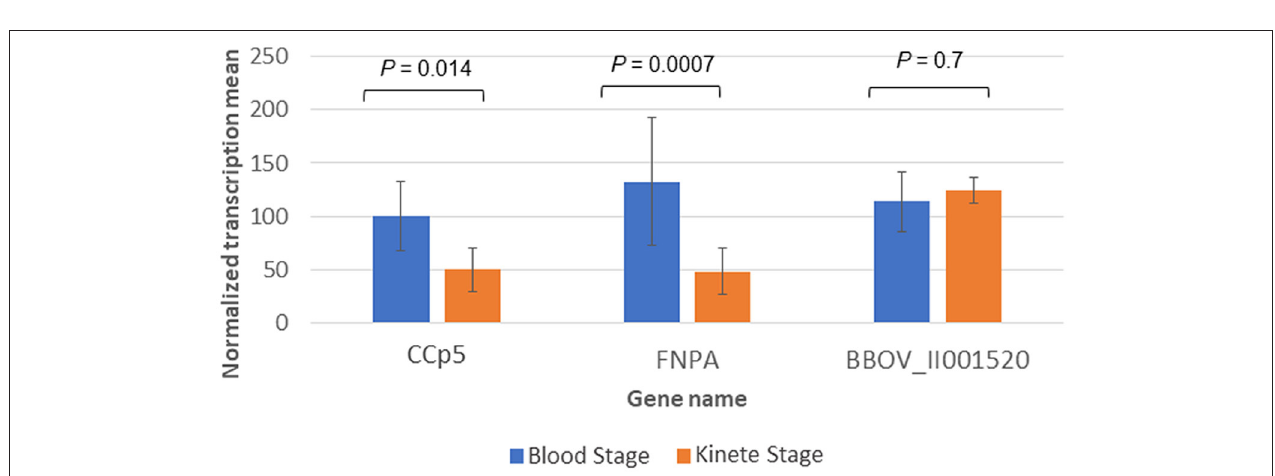
FIGURE 4 | (A) The RT-PCR analysis for the detection of RAP-1 , 6-Cys A , CCp5 and FNPA transcripts was performed using non-induced (blood stage-NIC) and induced (12, 24 and 48h) in vitro cultures (XA, xanthurenic acid induction; C, temperature induction; PC, positive control. (B) Relative expression of B. bovis CCp5 and FNPA by non-induced (blood stage) and induced stages (12, 24, and 48h) in vitro cultures. * p = 0.0.012–0.0028; ** p < 0.0001 ( p value compared with blood stage).